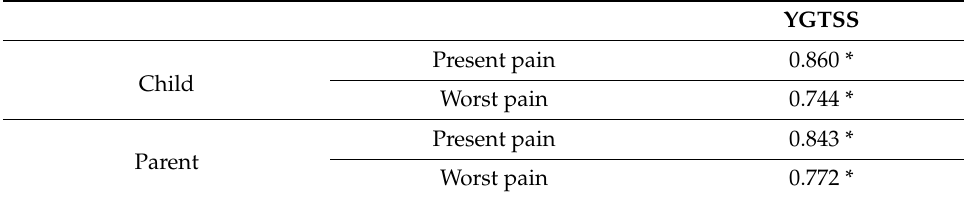
Table 2. The correlations between the scorings of pain intensity and tic severity.